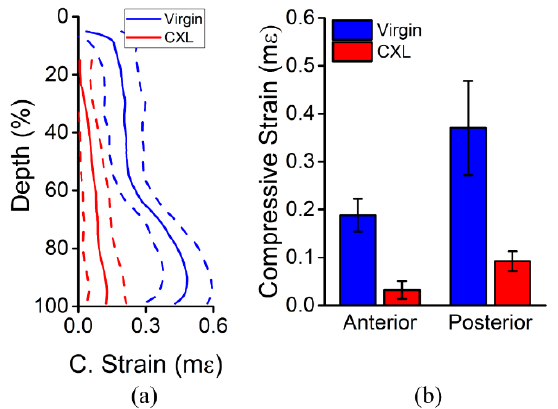
Figure 10. Depth-wise analysis of the full-CXL in vivo rabbit cornea (N = 1). ( a ) Laterally averaged and ( b ) regional analysis of the compressive strain before and after CXL. The solid lines in ( a ) are the mean, and the dashed lines are one standard deviation of error. The data in ( b ) is the intra-region mean ± standard deviation.